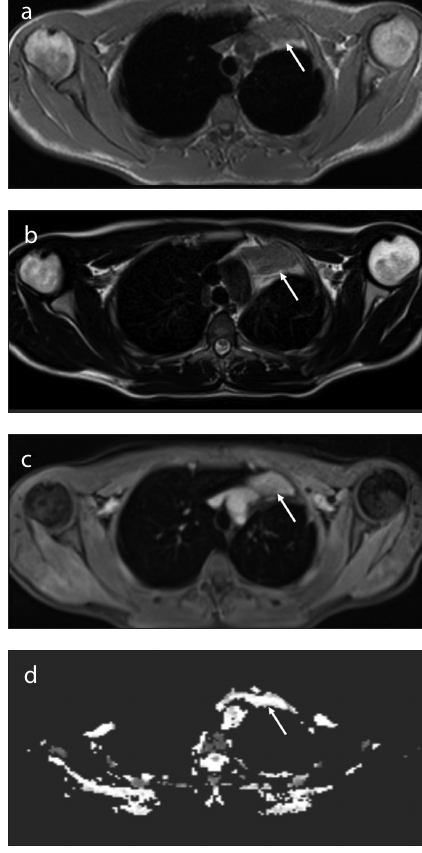
Figure 3. a-d. A 12-year-old male with a pathologically confirmed carcinoid tumor in the left upper lobe. Axial T1-weighted image (a) reveals the iso-hypointense carcinoid tumor (white arrow). Axial T2-weighted image (b) reveals a hypointense carcinoid tumor (white arrow). Axial postcontrast enhancement T1- weighted image (c) reveals contrast enhancement in carcinoid tumor (white arrow). Axial diffusion- weighted (ADC map) image (d) reveals no diffusion restriction (white